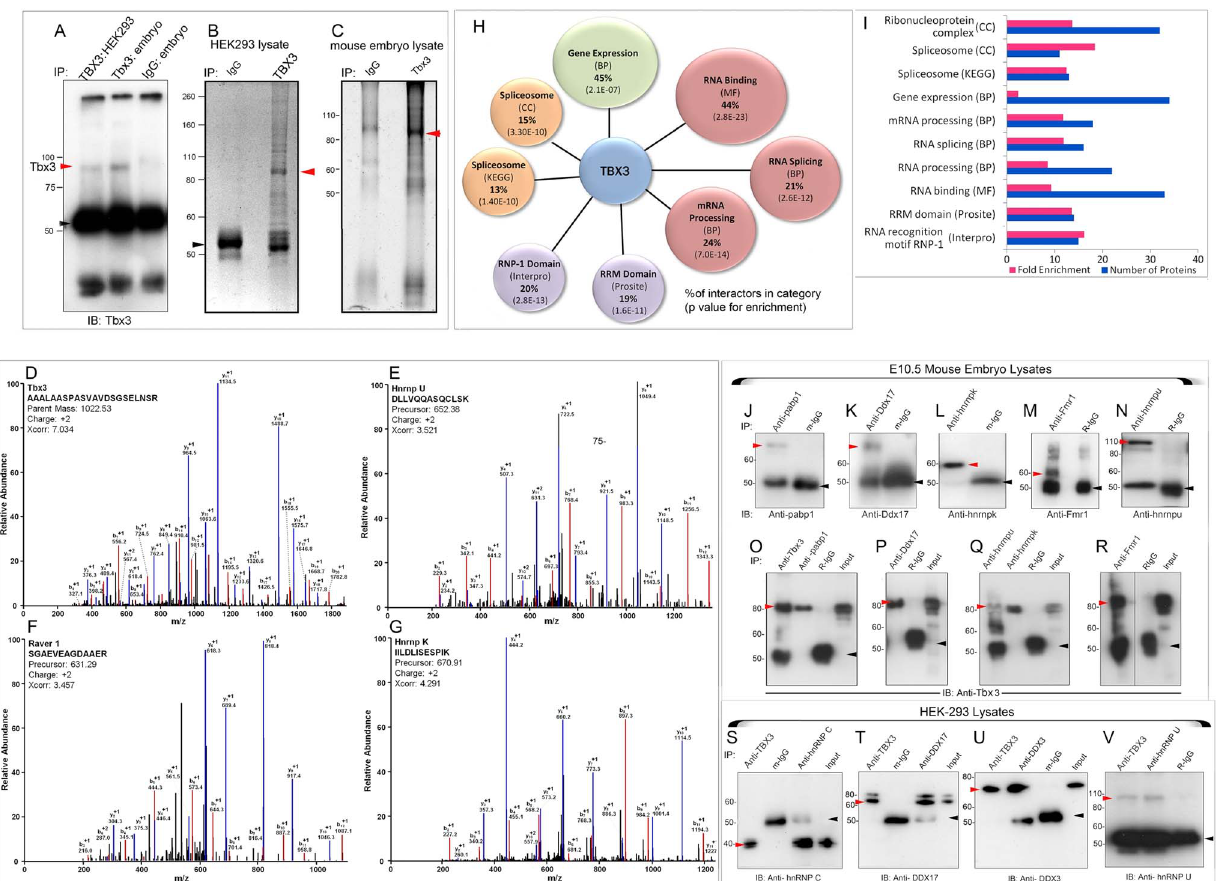
Figure 1. Splicing factors and RNA BPs are over-represented in the Tbx3 interactome identified by MS and are validated co- immunoprecipitation. A) Immunoblot (IB) detecting endogenous TBX3/Tbx3 protein immunoprecipitated (IP) from HEK293 and mouse embryo lysates, respectively. black arrowhead: IgG. B, C) Representative, Coomassie (B, 4–12% gradient) and Oriole stained (C, 10%) SDS-PAGE gels of anti- Tbx3 or negative control IgG IP’d complexes subsequently analyzed by MS. Red arrowheads, TBX3/Tbx3. D–G) Representative mass spectra for identification of Tbx3 (D) and interacting proteins: Hnrnp U (E), Raver 1 (F), Hnrnp K (G). Diagnostic b- and y-series ions are shown in red and blue. H) Gene ontology (GO) analysis identified predominant molecular functions and biological processes of Tbx3 interacting proteins. Diagram shows percent interacting proteins annotated with each GO term (molecular function, MF; biological process, BP; cellular component, CC; functional domain (Interpro and Prosite) and molecular pathway (KEGG). I) Bar graph of number of proteins and fold enrichment per category. J–V) Mouse embryo and HEK293 lysates were immunoprecipitated with the antibody listed at the top of the panels (IP) and the antibodies used to probe the immunoblot (IB) below. J–N) Immunoprecipitation of endogenous: pabp1, Ddx17, hnrnp k, Fmr1, hnrnp u from e10.5 mouse embryo lysates. red arrowheads: interacting protein; black arrowheads: IgG O–R) Endogenous Tbx3 coIPs with pabp1 (O), Ddx17 (P), hnrnp k and hnrnp u (Q), Fmr1 (R) in e10.5 mouse embryos. S–V) Endogenous TBX3 coIPs with hnRNP C (S), DDX17 (T), DDX3 (U) and hnRNP U (V) in HEK293 cells. Red arrowheads: interacting protein; black arrowheads: IgG.